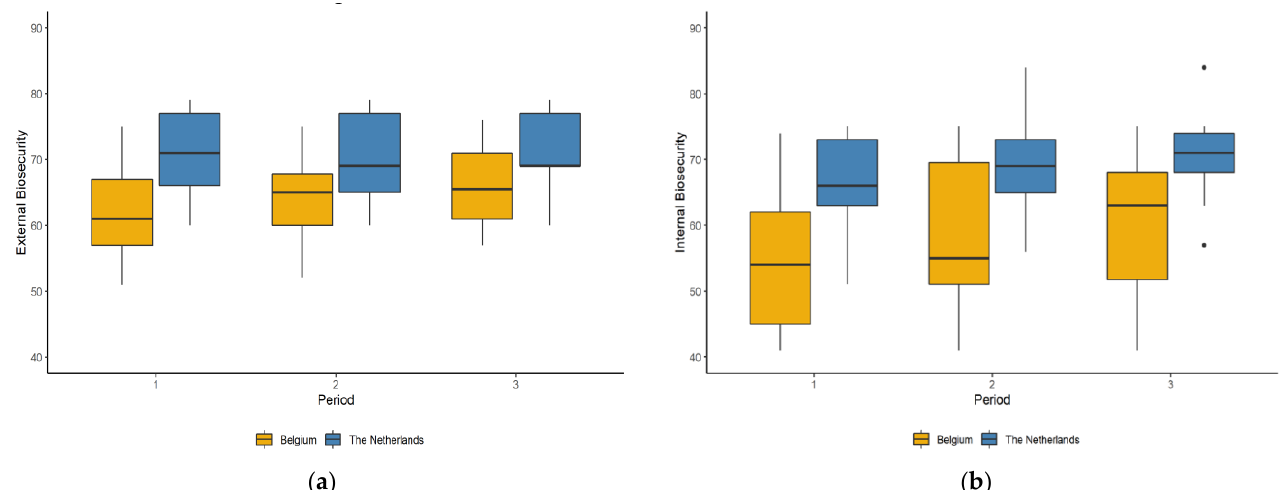
Figure 1. Distribution of ( a ) external and ( b ) internal biosecurity levels for participating Belgian ( n = 15) and Dutch ( n = 13) farms per coaching period. The higher the biosecurity scores are on the y -axis, the better the disease prevention measures in place are. The line within each box represents the median value. The lower and upper boundaries of each box correspond to the 25th and 75th percentiles, respectively. Whiskers below and above each box show the 10th and 90th percentiles. Points below and above the whiskers represent outliers.